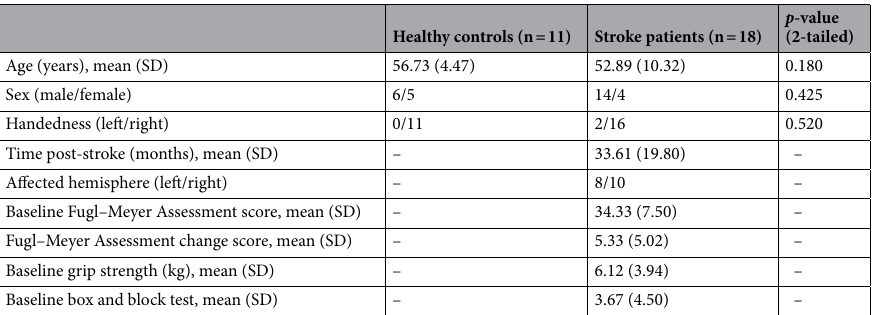
Table 1. Subject demographic and behavioral characteristics. Independent t test was performed to compare the group difference in age. Fisher’s exact test was performed to compare the group difference in sex and handedness separately. There was no significant group difference in age, sex, and handedness ( p > 0.05). Fugl– Meyer Assessment change score refers to the change after motor imagery-assisted brain computer interface- based training with and without transcranial direct current stimulation intervention (i.e., post-intervention minus